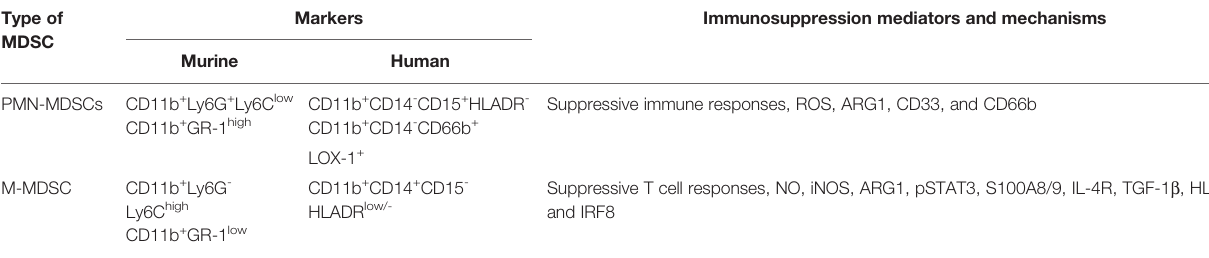
TABLE 1 | Two categories of myeloid-derived suppressor cells and functions. Type of